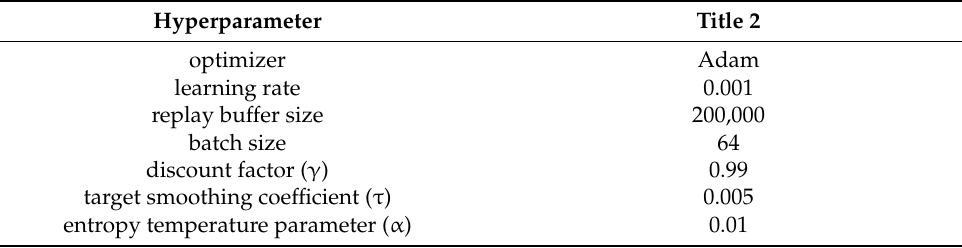
Table 1. Hyperparameters of SAC neural